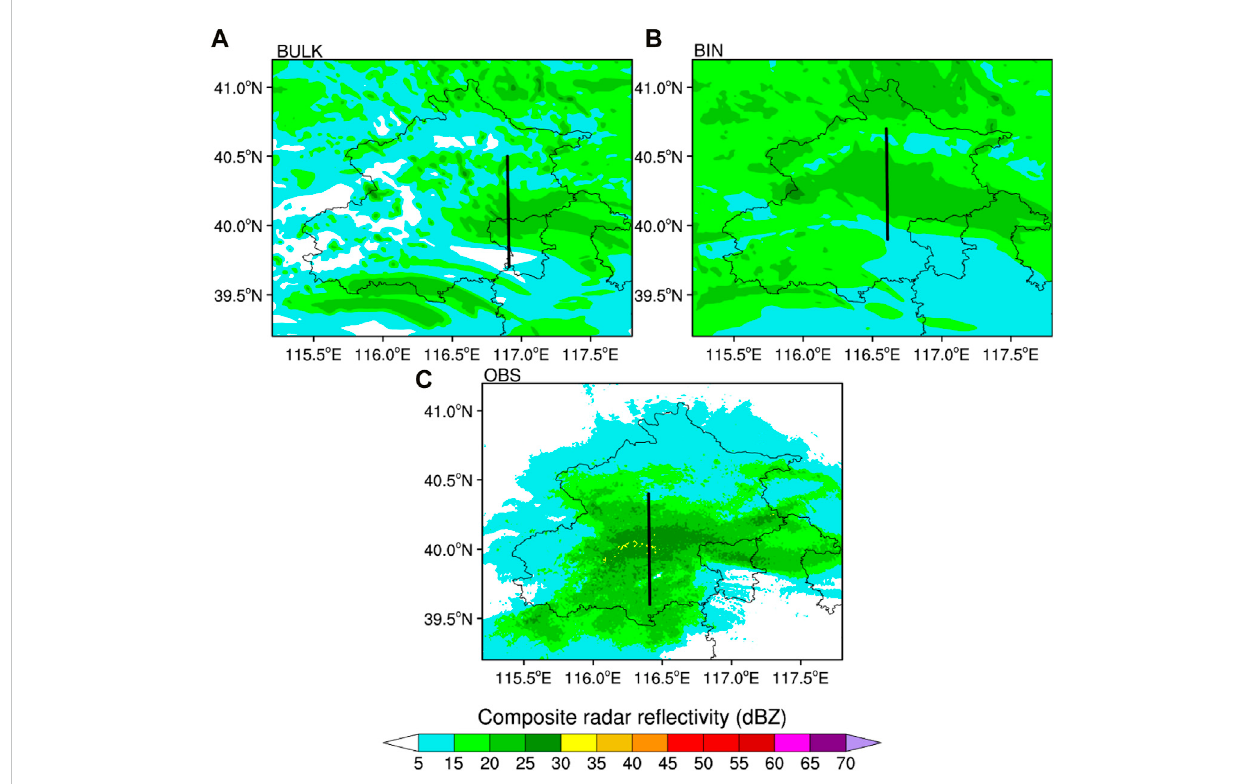
Composite radar re fl ectivity of (A) the BULK scheme and (B) the BIN scheme at 0400 UTC on February 13, 2022, and (C) observed composite radar re fl ectivity at 0300 UTC on February 13, 2022. Black lines denote the locations of the cross sections shown in Figure